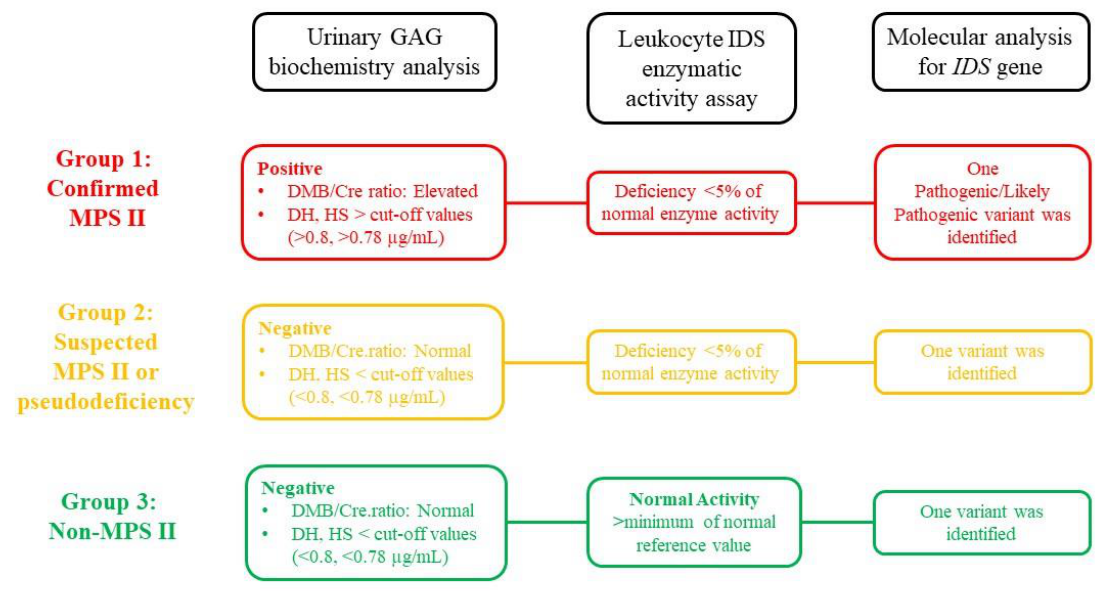
Figure 1. The referred infants from our MPS II newborn screening program were classified into three diagnostic groups as follows: Group 1: confirmed MPS II, Group 2: suspected MPS II or pseudodefi- ciency, and Group 3: non-MPS II according to the results of urinary GAG biochemistry tests, leukocyte IDS enzymatic activity assay, and molecular analysis of the IDS gene. MPS, mucopolysaccharidosis; GAG, glycosaminoglycan; IDS, iduronate-2-sulfatase; DS, dermatan sulfate; HS, heparan sulfate.